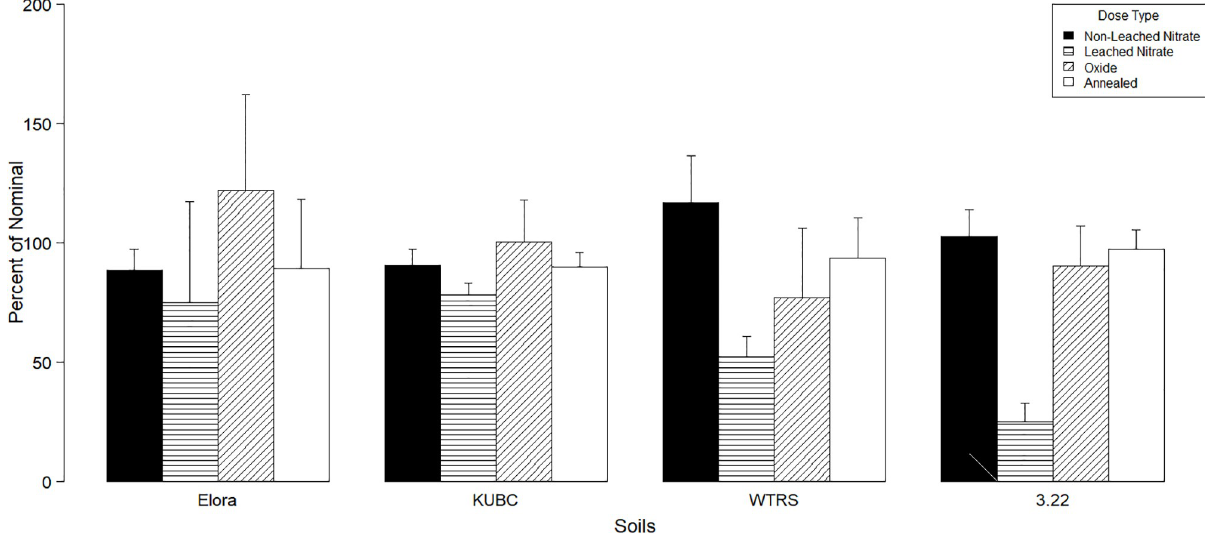
Fig 1. Effect of dosing method on total metal concentrations by soil. Average percentage of nominal total metal concentration (all elements combined) across all mixture ratios (R1—Port Colborne, R2—CSQG, R3—Flin Flon, R4—Sudbury and R5—Clay peat), in each soil according to dosing method. Error bars represent the standard deviation (n =